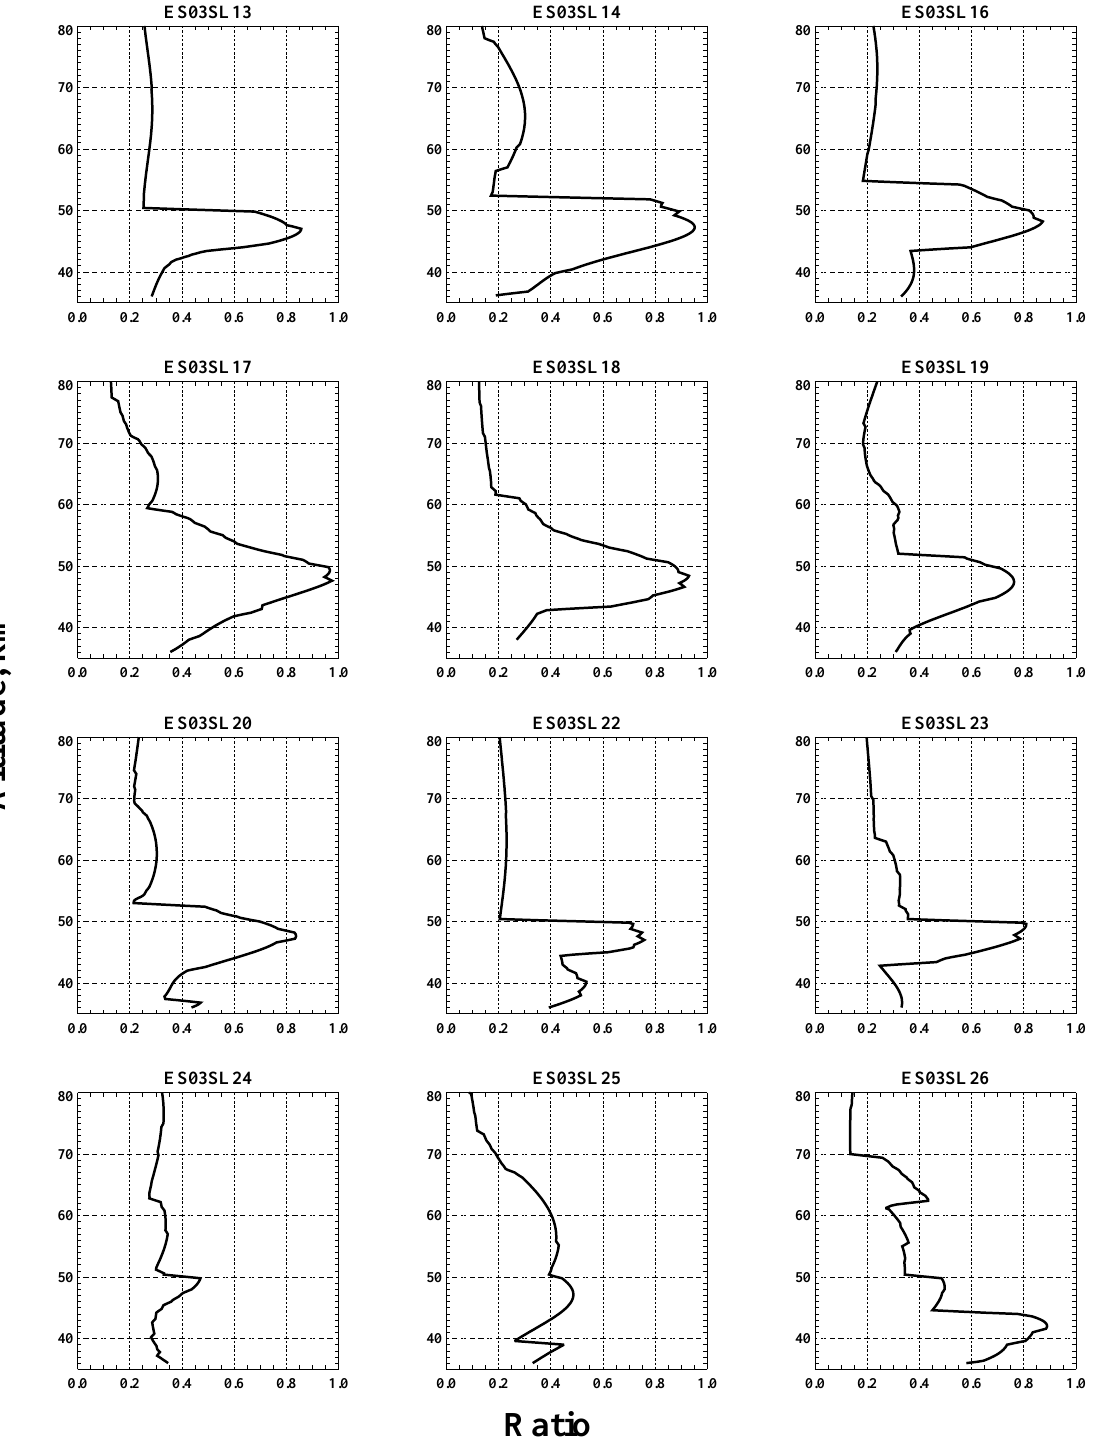
Fig. 11. Vertical profiles of the ratios of wind perturbation amplitude, u 0 h , and intrinsic phase speed, ˆ c , for the FS soundings in Salvo 1. The third sounding was excluded due to its limited vertical extent. The label on each plot is the sounding number. See text for further details.